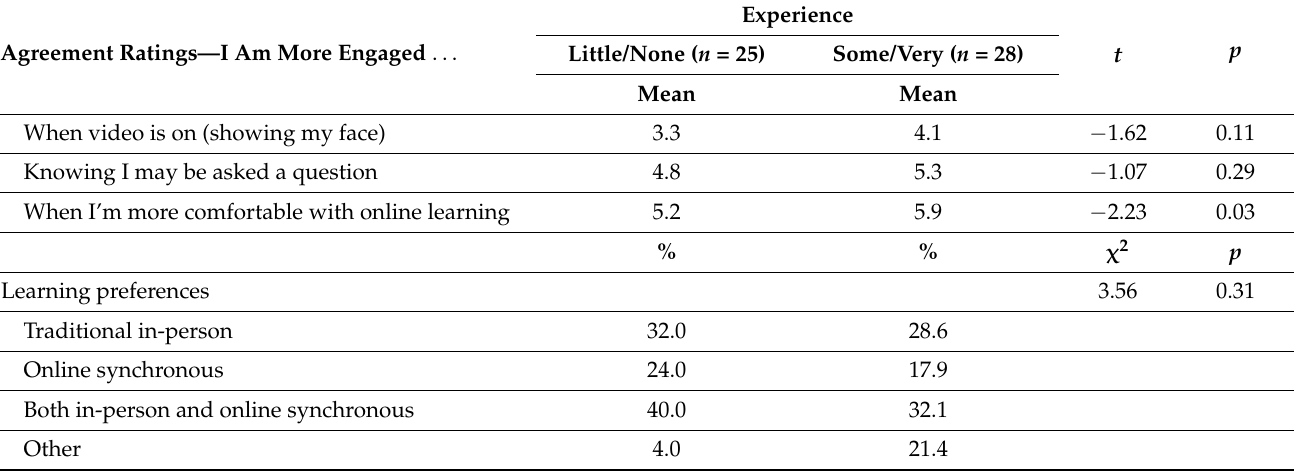
Table 2. Comparisons * of agreement ratings with factors promoting engagement and learning preferences between those who were less vs. more experienced with videoconferencing before March 2020 (N = 53).